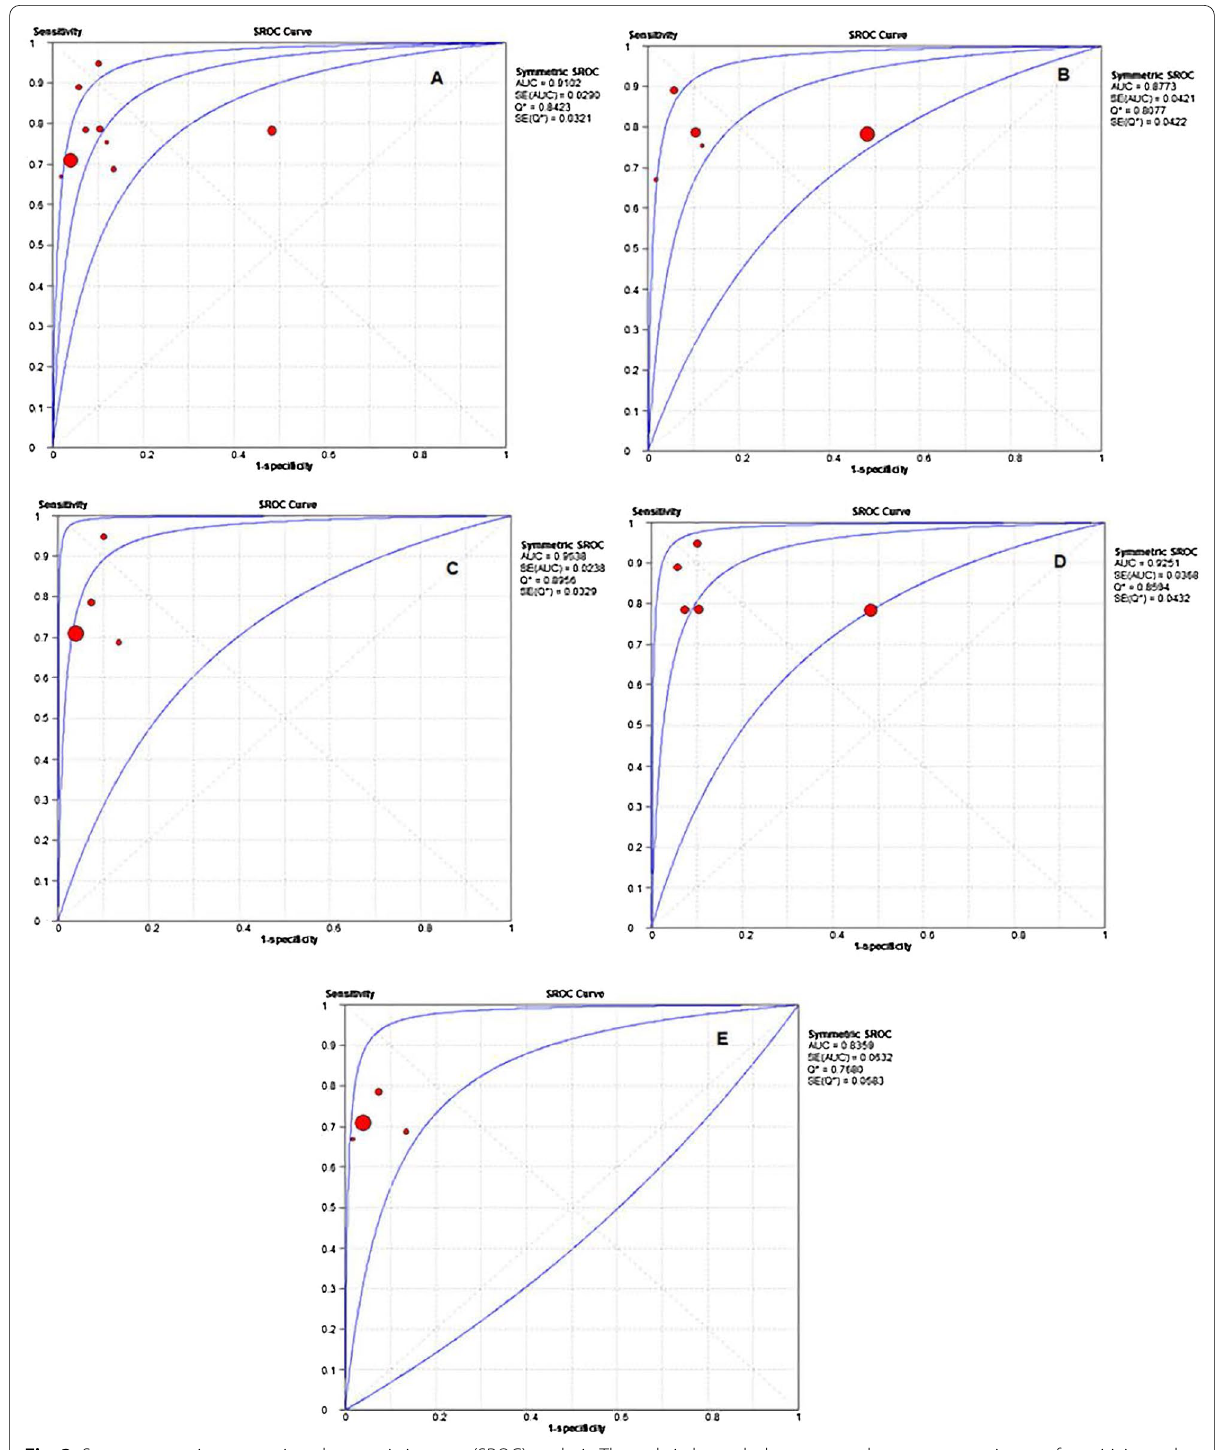
Fig. 3 Summary receiver operating characteristic curve (SROC) analysis. The red circle symbol represents the summary estimate of sensitivity and specificity of the C 2 HEST score using a bivariate random-effects regression model. A dotted line surrounds the circle represents the 95% confidence interval. AUC area under the curve. A The overall AUC, B Asian, C non-Asian, D general population, and E chronic